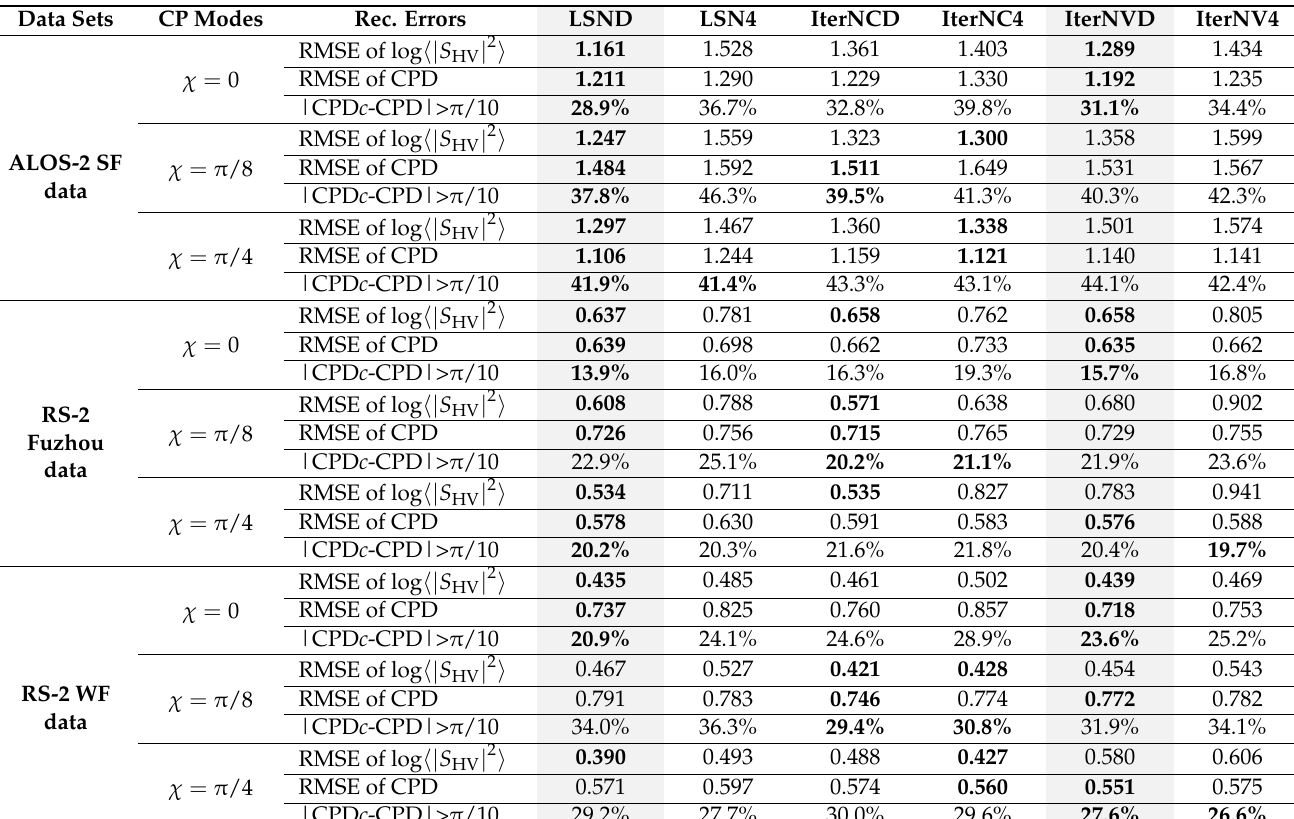
Table 2. Quantitative evaluation for log (cid:104)| S HV | 2 (cid:105) and CPD by using the root mean square error (RMSE) and the percentage of pixels deviating from the real values by 5% of the total range. Three CP modes illustrated are ( θ = π /4, χ = 0 ) , ( θ = π /4, χ = π /8 ) , and ( θ = π /4, χ = π /4 )